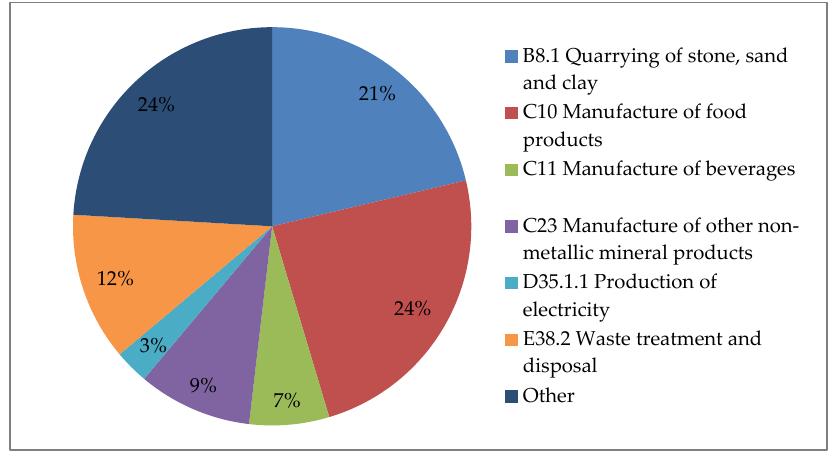
Figure 8. Cypriot participants type profile. Table 2. Cypriot participants waste type profile.